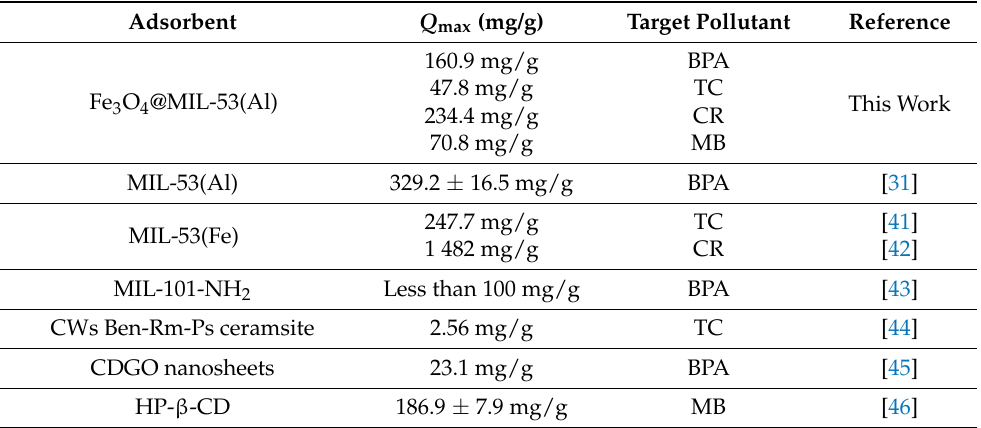
Table 4. Comparison of the Fe 3 O 4 @MIL-53(Al) uptake with some previous